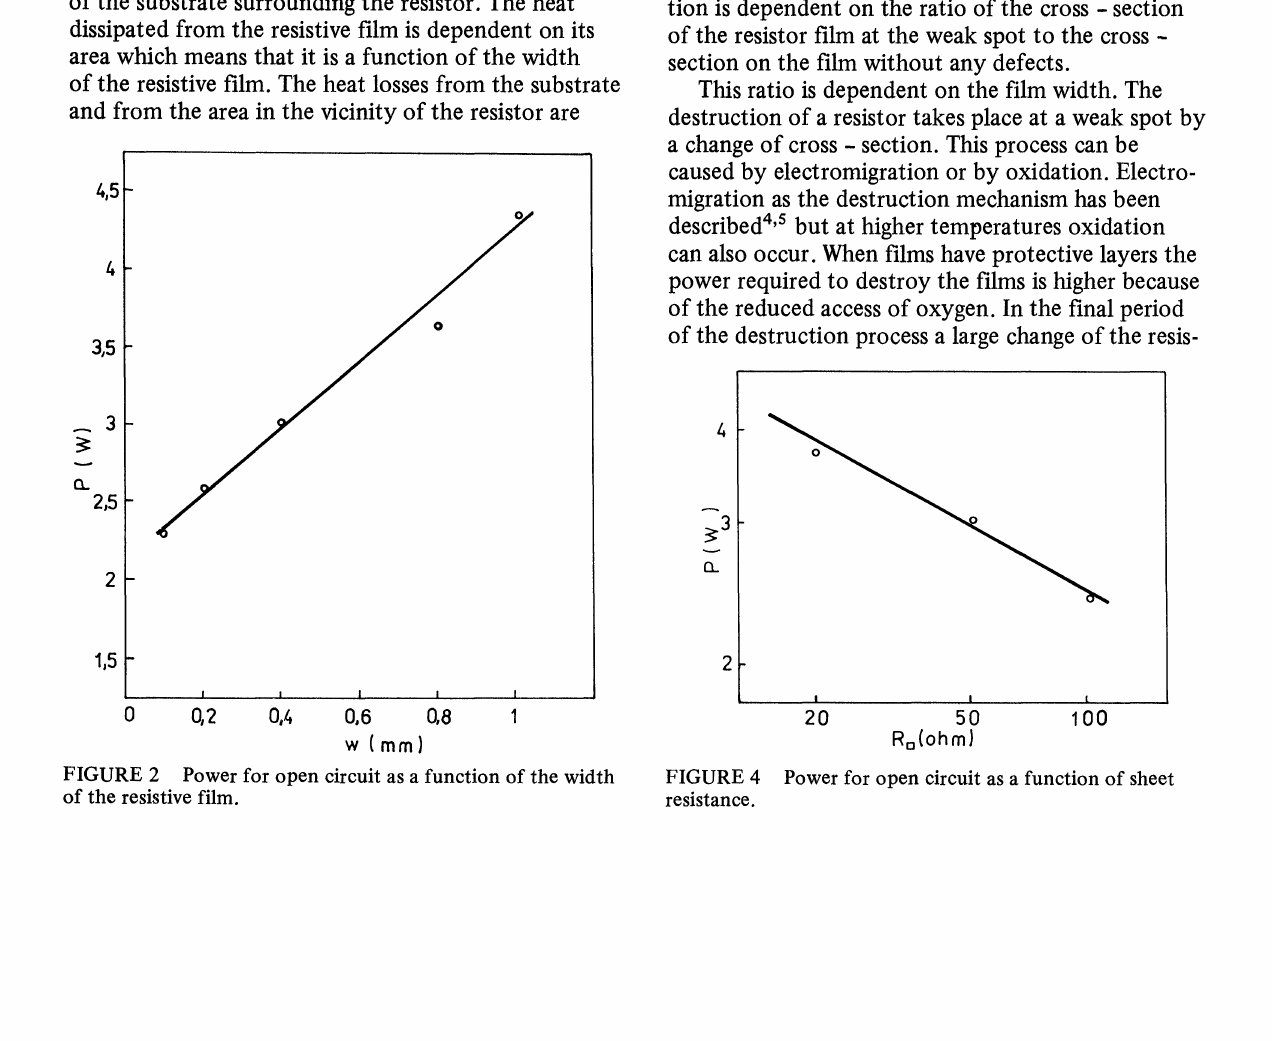
FIGURE 4 Power for open circuit as a function of sheet